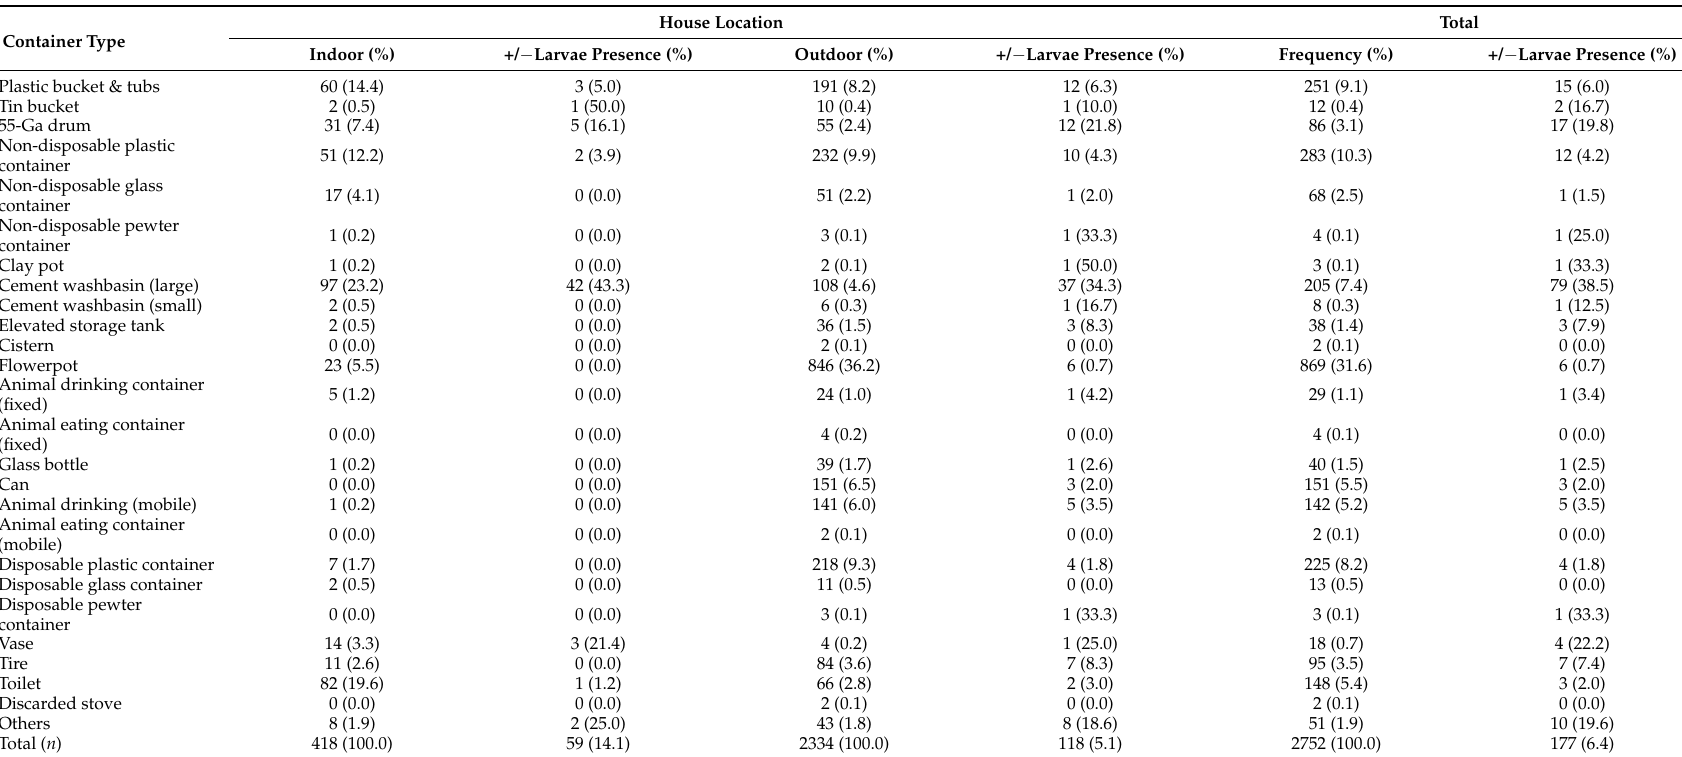
Table 1. Aedes aegypti larvae breeding sites found in the El Vergel, Tapachula, Chiapas, 13–30 August 2019, using the traditional field technician’s surveillance (ground surveillance). Containers by house location and positive containers for larvae presence for every 26